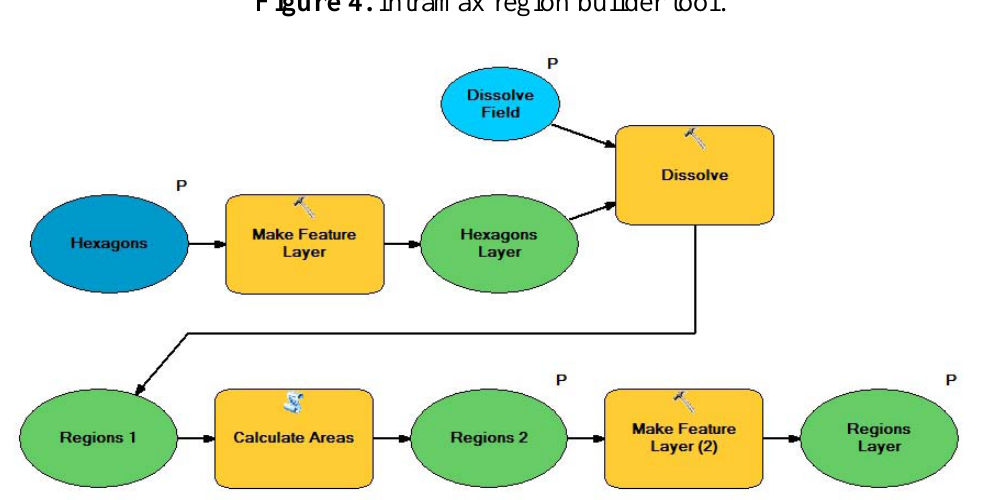
Figure 4. Intramax region builder tool.